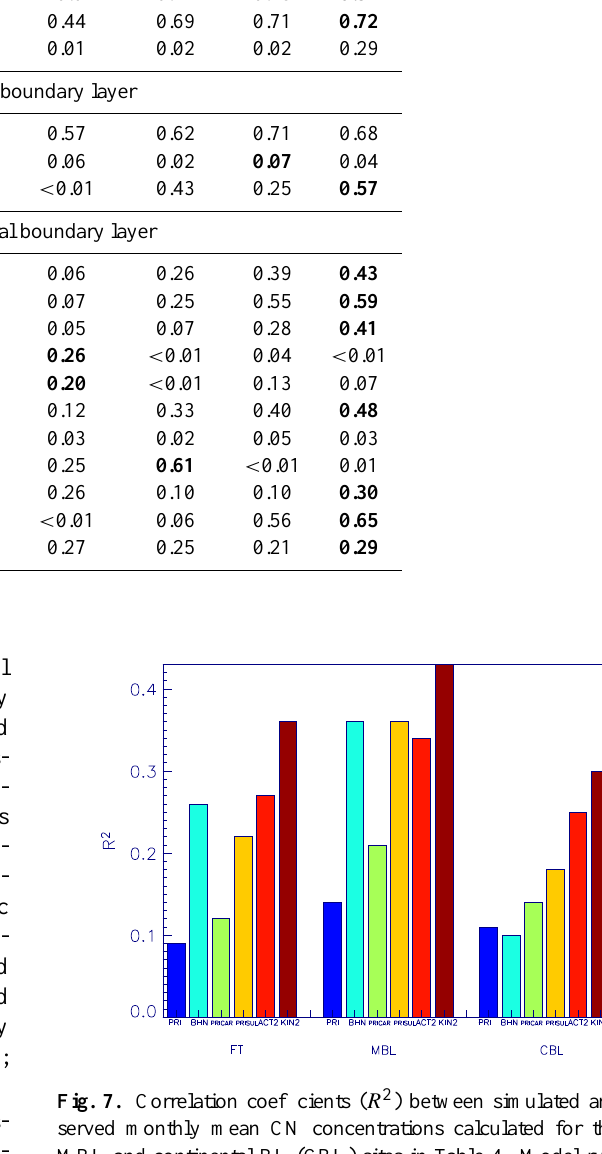
sonal cycle of CN in the FT (activation, R 2 = 0 . 27; kinetic, R 2 = 0 . 36), MBL (activation, R 2 = 0 . 34; kinetic, R 2 = 0 . 43) and continental BL (activation, R 2 = 0 . 25; kinetic, R 2 = 0 . 30) was well